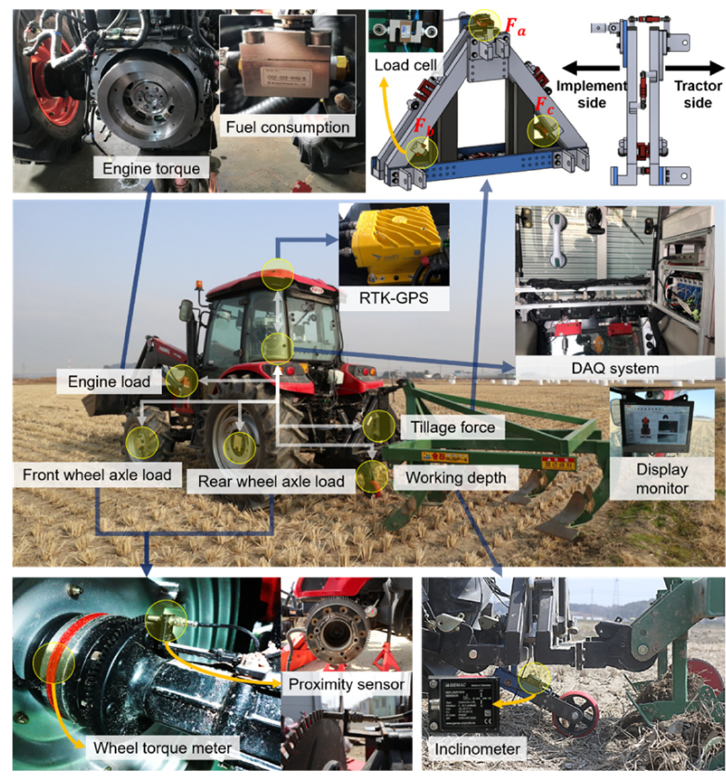
Figure 2. Configuration of field load measurement system.